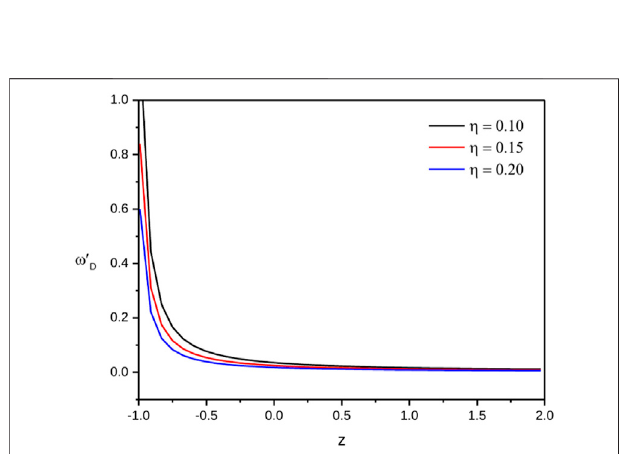
FIGURE 13 | Plot of ω D ′ of Pilgrim dark energy f ( Q ) gravity model versus redshift for the appropriate choice of constants.